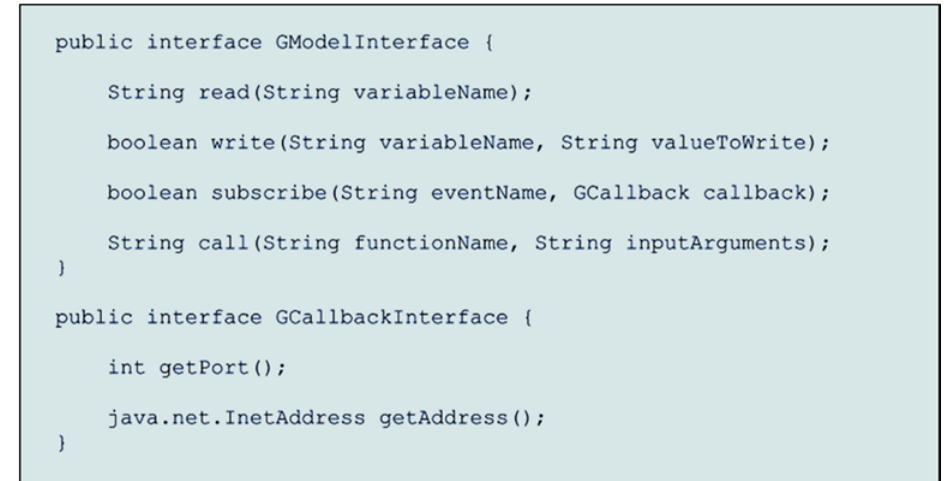
Figure 2. Application programming interface (API) Operations Signature.